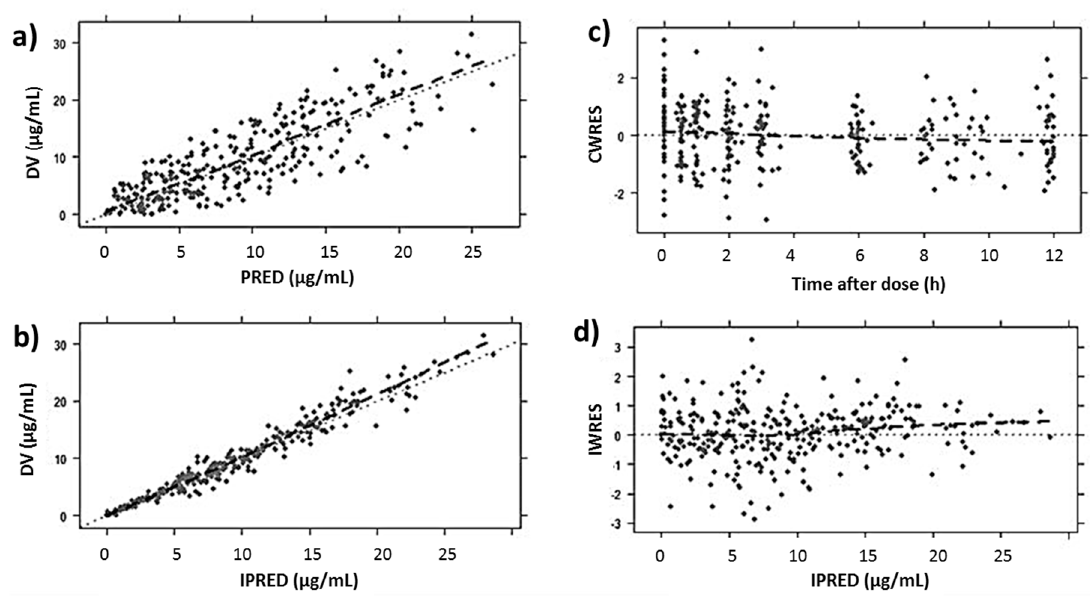
Figure 1. GOF plots obtained for the final model: ( a ) population predictions (PRED) and ( b ) individual predictions (IPRED) against observed linezolid plasma concentrations (DV, µg/mL), ( c ) conditional weighted residuals (CWRES) versus time after dose (h), and ( d ) the individual weighted residuals (IWRES) versus individual concentration predictions (µg/mL).